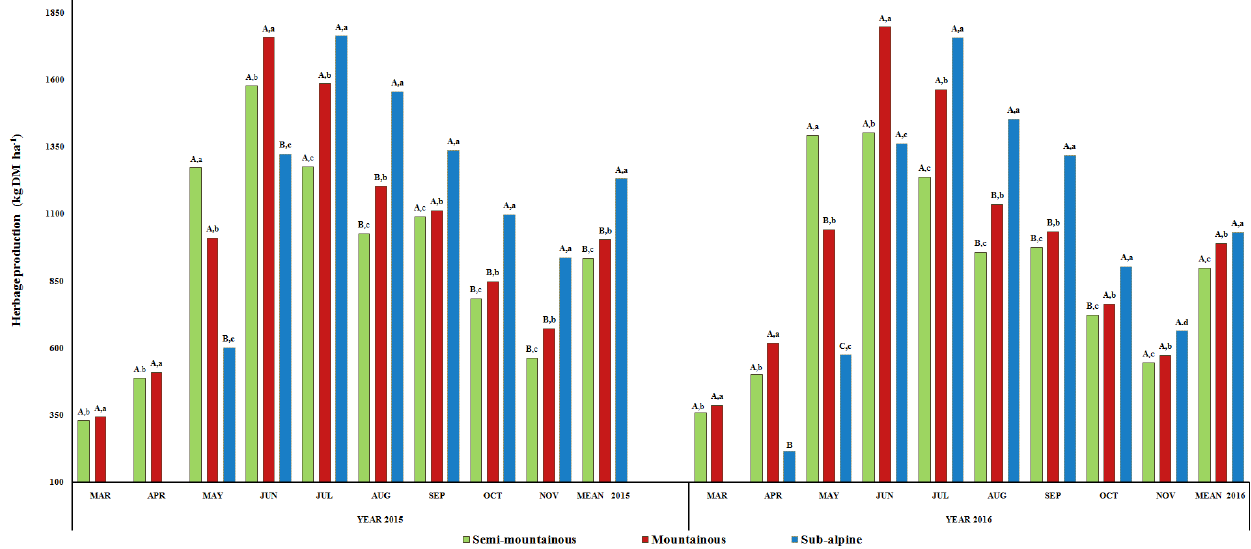
Figure 1. Interannual and monthly variation of herbage production (kgDMha − 1 ) of the semi-mountainous, mountainous and sub-alpine grasslands in the Florina Prefecture, northern Greece. Means of the three grasslands between the 2-year experimental period followed by different letters (a–d) along the corresponding bar differ at P < 0 . 05. Means of the three grasslands in the same year of the experimental period followed by different capital letters (A–C) along the corresponding bar differ at P < 0 . 05. Table 2. Effect of harvest time (month and year) and altitudinal zone on herbage production and nutritive value. Parameter Month Zone Year Month Month Zone Month x zone Herbage production